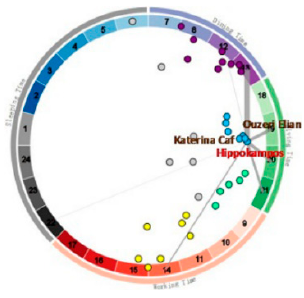
Figure 40. Identifying location types in digital-forensics process via Radviz [104].